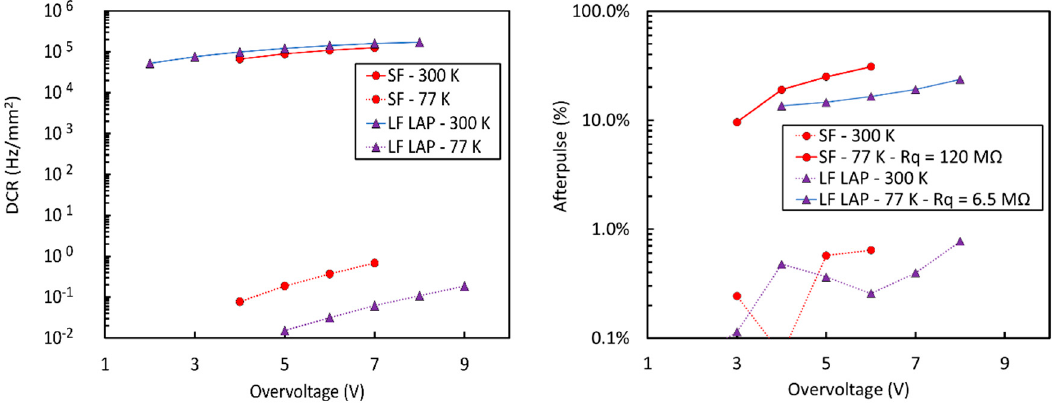
Figure 23. ( left ) DCR measured at 293 K and 77 K on 25 µ m cell NUV-HD and NUV-HD–Cryo SiPMs; ( right ) Afterpulsing probability measured at 293 K and 77 K on 25 µ m cell NUV-HD and NUV-HD–Cryo SiPMs with values of quenching resistor of 120 MOhm and 6.5 MOhm, respectively.